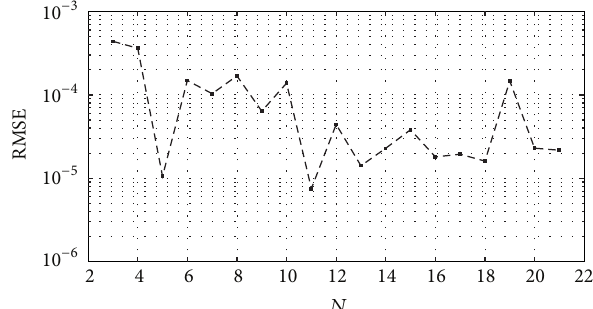
Figure 3: The RMSE curve versus the center nodes with 𝛽 = 14 .